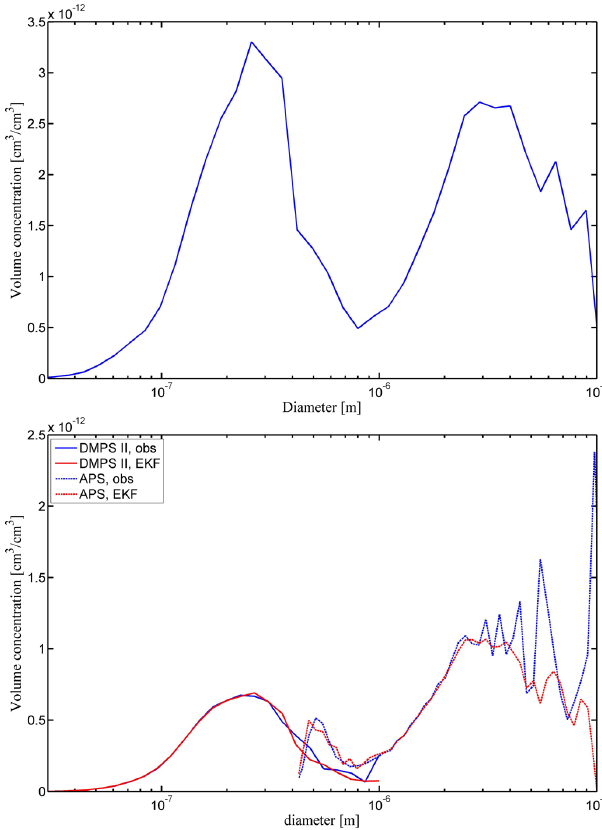
Fig. 3. The estimated volume concentration size distribution in 300– 2000nm at 12:00, 7 May 2010 from SMEAR II in Hyyti¨al¨a, Finland (top panel). The observations (blue) and corresponding estimate cal- culated with H (red) from 300nm to 10µm for DMPS II (solid) and APS (dashed) from 12:00 on 7 May 2010 from SMEAR II in Hyyti¨al¨a, Finland (bottom panel). Volume concentrations are on the y-axis [cm 3 cm − 3 ] and particle diameter on the x-axis